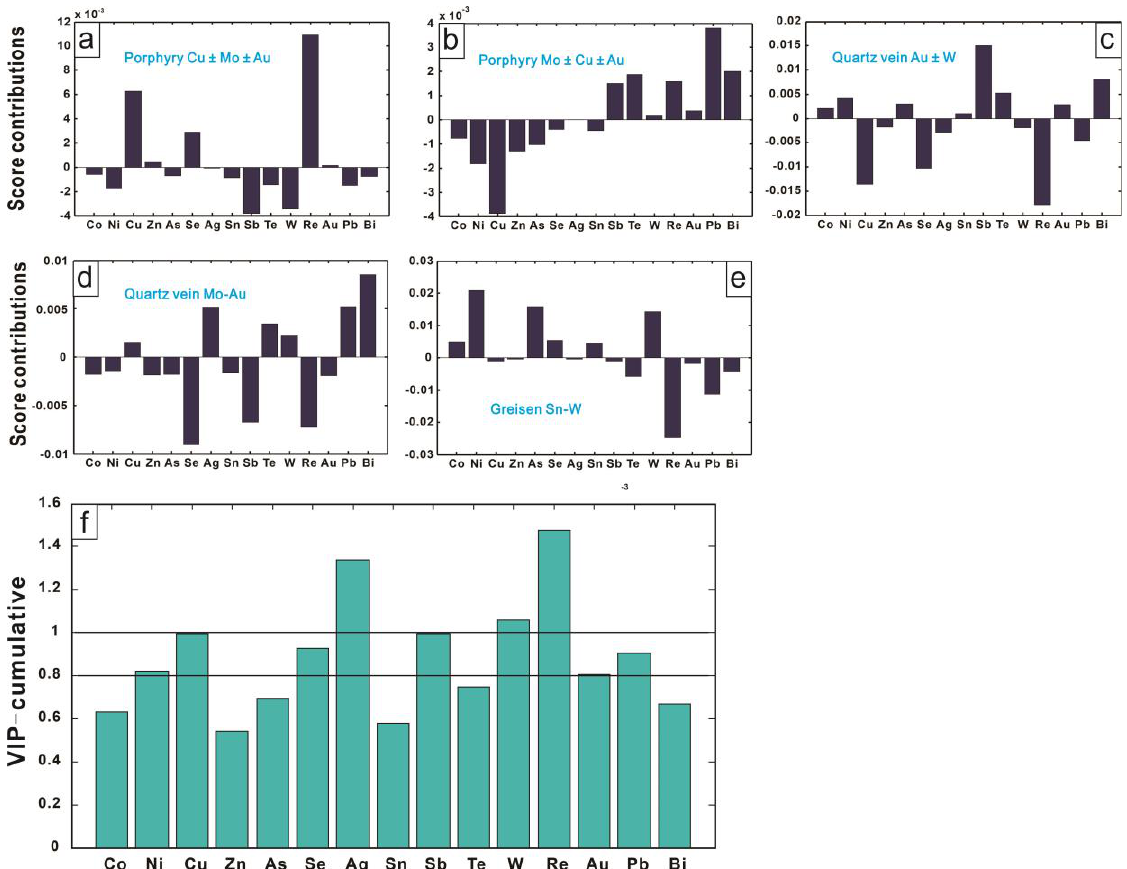
Figure 6. Score contribution ( a – e ) and VIP-cumulative plot ( f ) corresponding to PLS-DA results in Figure 5.